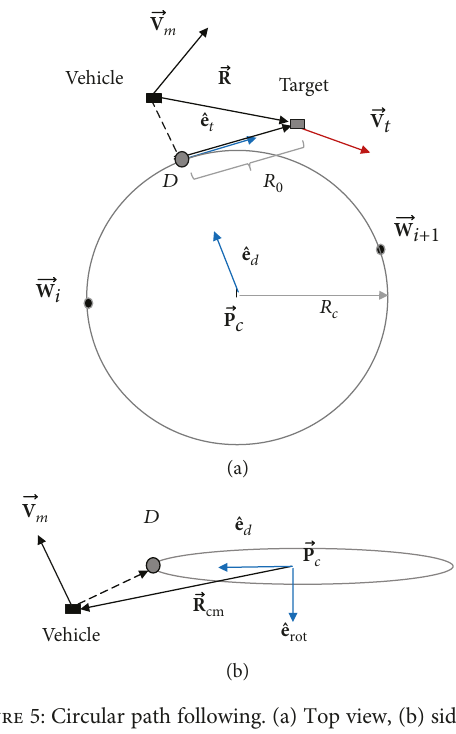
Figure 5: Circular path following. (a) Top view, (b) side